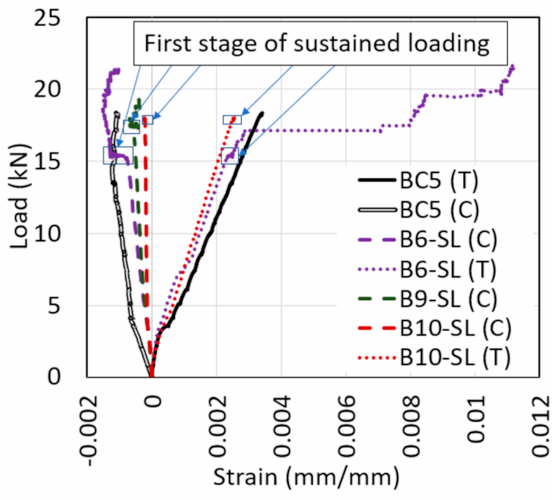
Figure 21. Load vs. strain for beams series II.